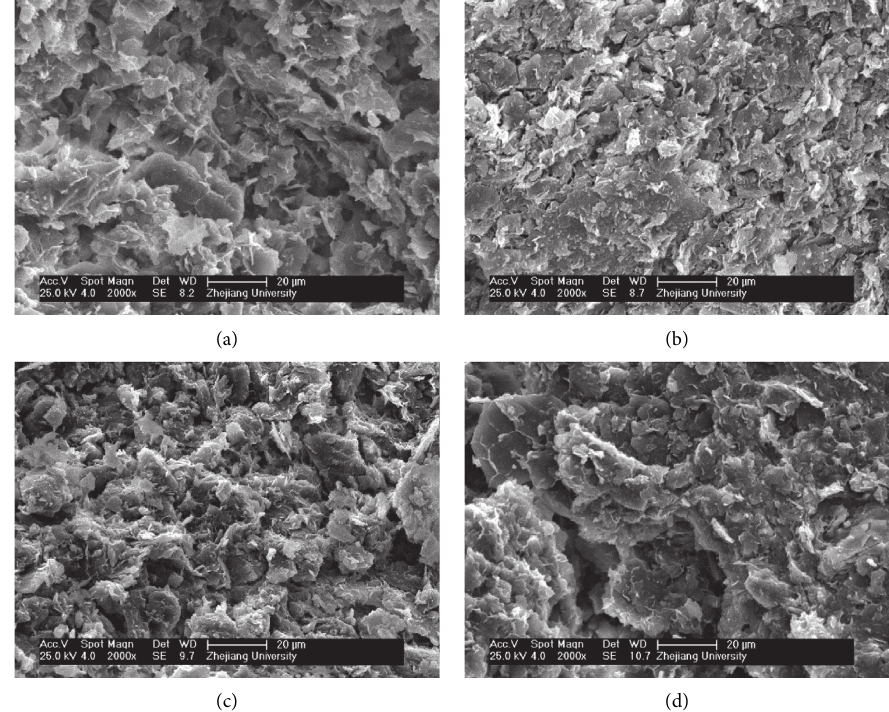
Figure 12: SEM images. (a) Soil before treatment. (b) Anode soil after treatment. (c) Middle soil after treatment. (d) Cathode soil after